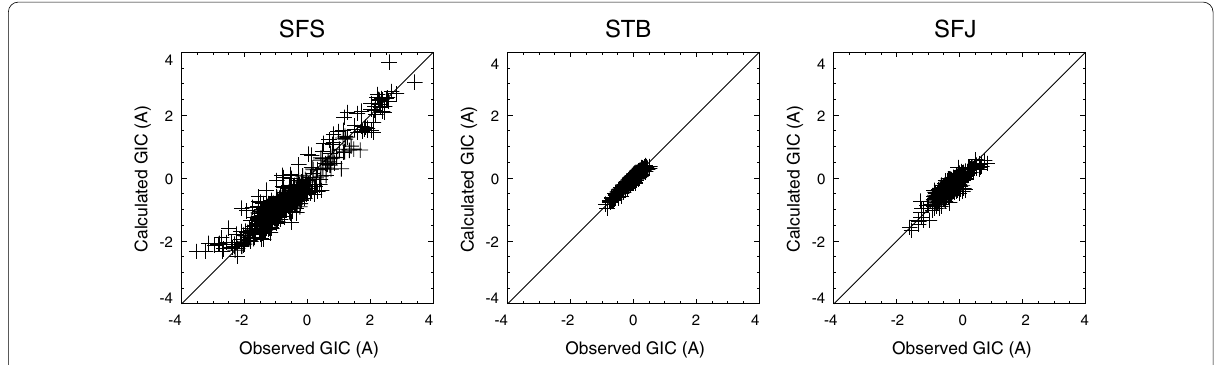
Fig. 4 Relationships between the calculated and observed GICs at (left) SFS, (middle) STB, and (right) SFJ